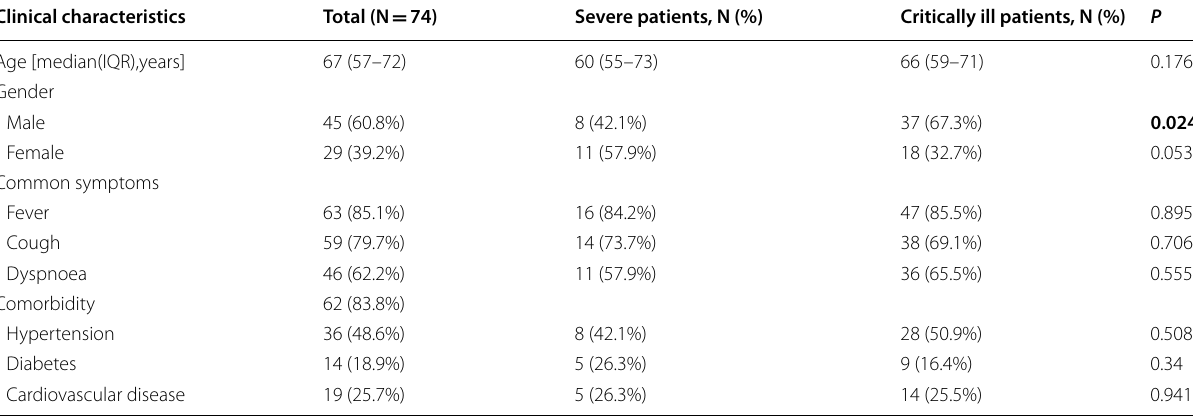
Bold indicates the statistically significant values ( P <